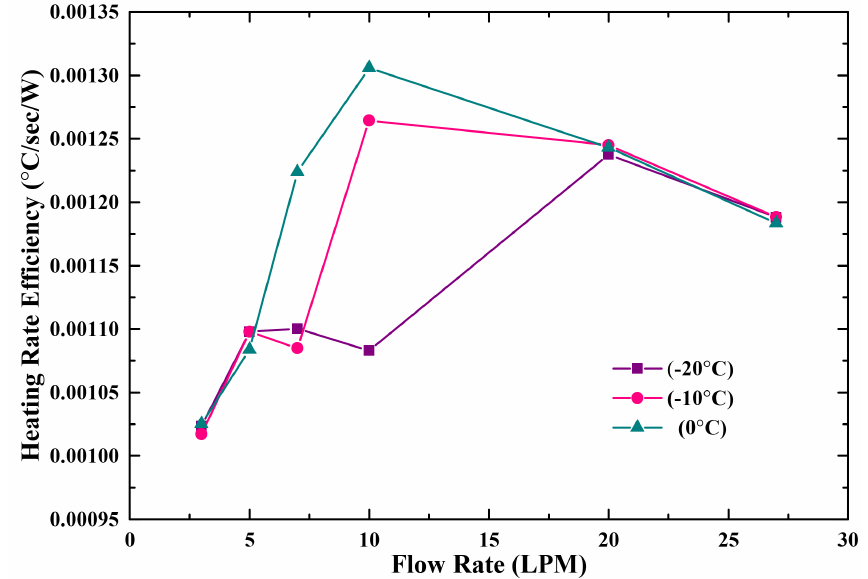
Figure 16. System overall efficiency with heater capacity: 4 kW.